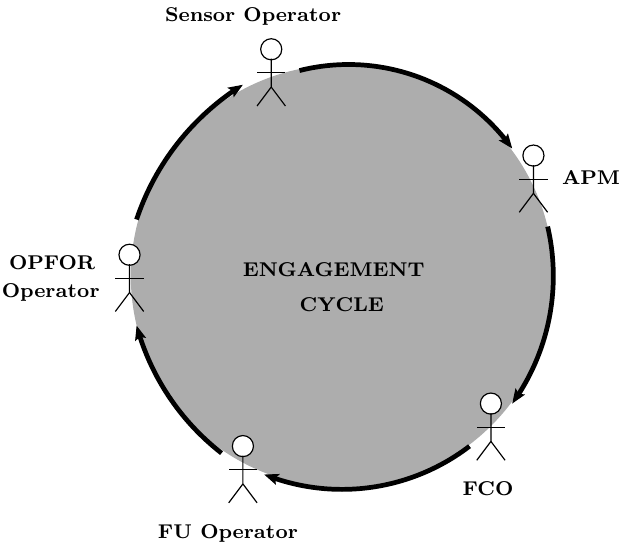
Figure 6: The classes of operators as part of an AD engagement cycle. These operators include, an Opposing Force (OPFOR) Operator, a Sensor Operator, an Air Picture Manager (APM), a Fire Control Operator (FCO) and a Fire Unit (FU)